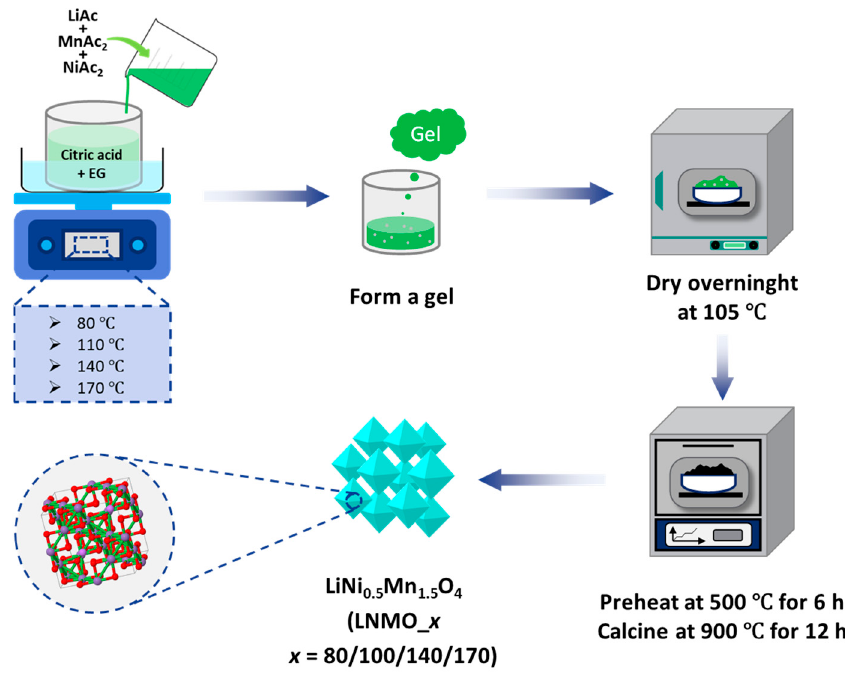
Figure 1. Illustration of the synthesis process of LNMO_ x samples.